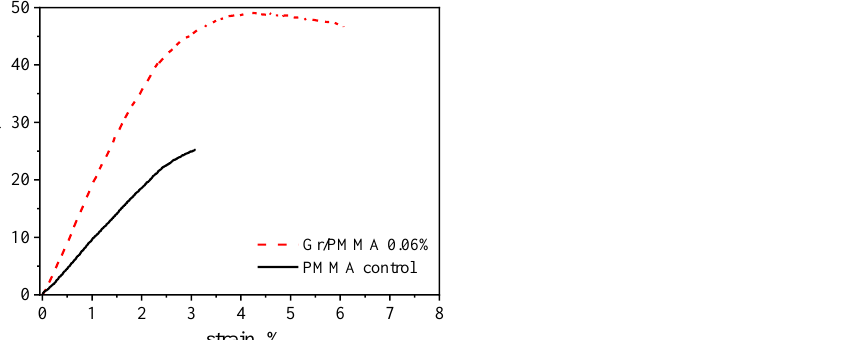
Figure 2. ( a ) Representative Raman spectra collected from the Gr-PMMA nanolaminate under investigation. ( b ) Contour map of the position of the G peak. ( c ) Box plots for Int(2D)/Int(G), Pos(2D), Int(D)/Int(G) and FWHM(2D).